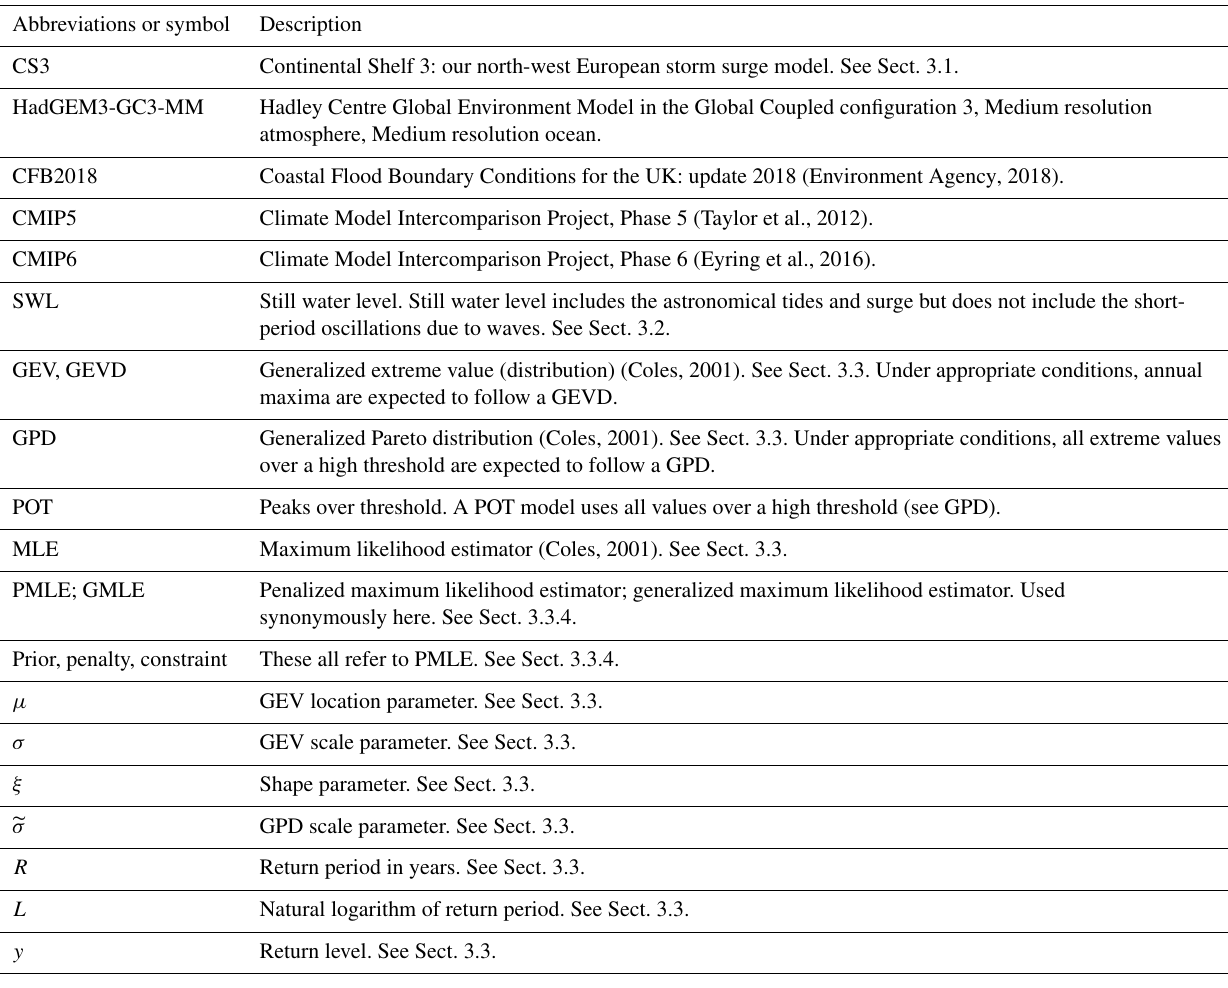
Table 1. Abbreviations and